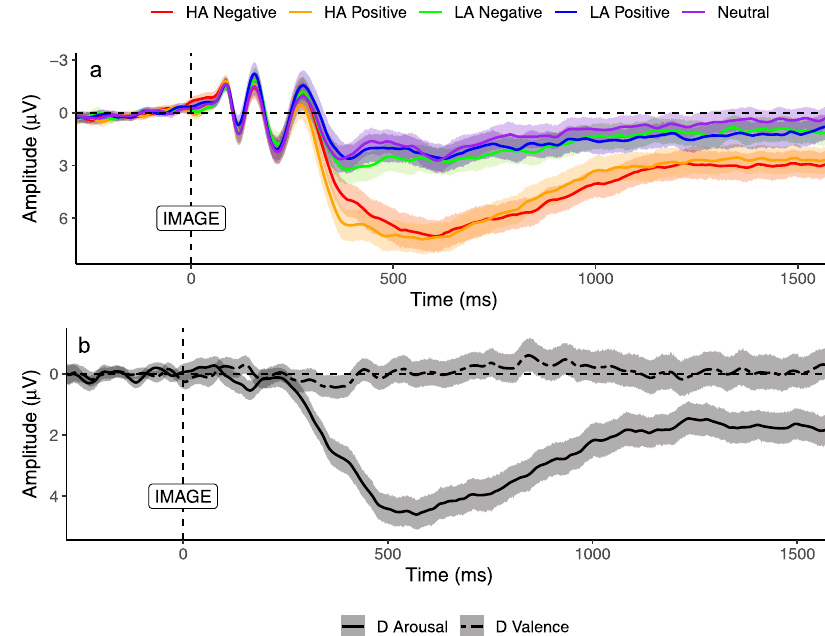
Fig. 3 Figure depicting LPP at electrode Pz. Central lines depict the grand average ERP amplitude across participants, and the shaded error bands denote 95% between-subjects con fi dence intervals (red: high arousal negative; orange: high arousal positive; green: low arousal negative; blue: low arousal positive; purple: neutral). a ERPs showing the LPP for every condition in the experiment. A 2 (valence: positive vs. negative) × 2 (arousal: high vs. low)× 2 (window: early LPP vs. late LPP) repeated-measures ANOVA was used to assess the LPP across image types revealed a signi fi cant three-way interaction, F(1, 189) = 23.34, p < 0.001. b ERPs showing the effect of valence (positive minus negative — dashed black line) and arousal (high minus low — solid black line) on the LPP amplitude. HA, high arousal image; LA, low arousal image; D denotes difference